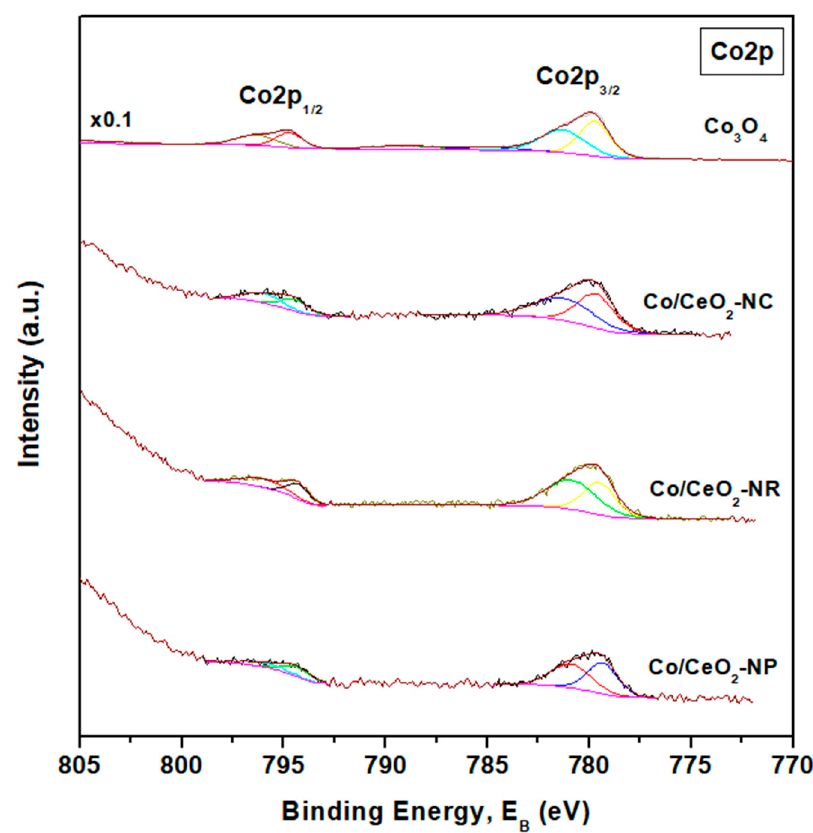
Figure 6. The Co 2p XPS spectra of the Co 3 O 4 and Co/CeO 2 samples: The Co 2p XPS spectra of Co/CeO 2 samples